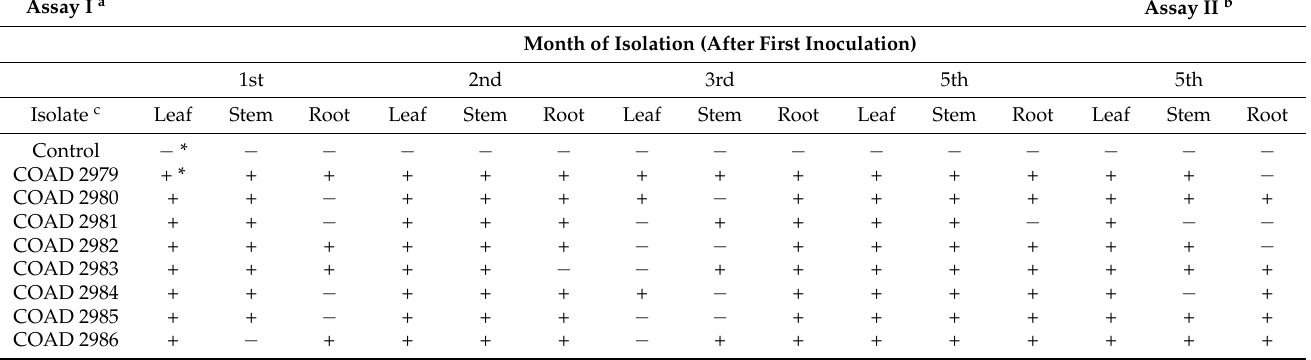
Table 3. Isolation of Clonostachys spp. demonstrating endophytic colonization of Coffea arabica in different tissues of inoculated vs. (control) noninoculated